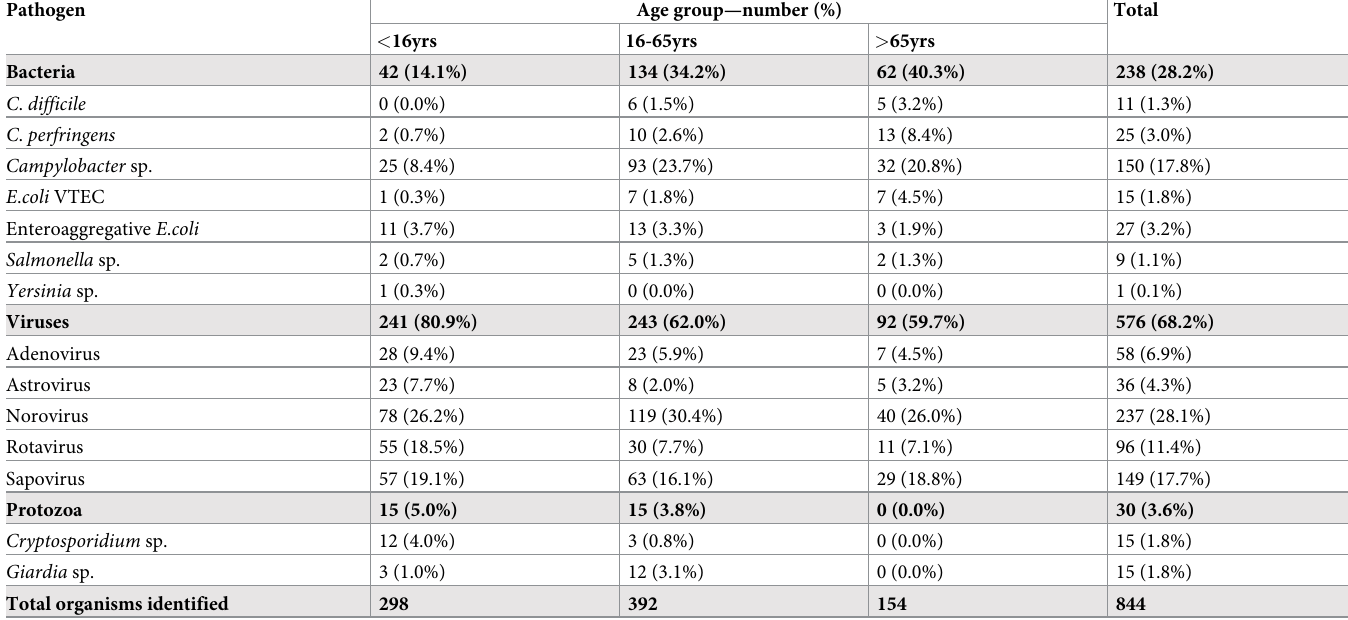
Table 2. The number and proportion of isolated organisms, by age